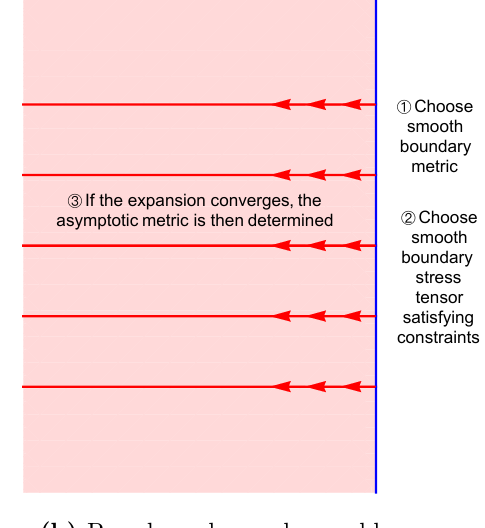
Figure 2. (a) Recipe for obtaining smooth bulk solutions given initial data and boundary data. (b) If the Fe(cid:11)erman-Graham expansion converges, one can obtain the asymptotic bulk solution from the boundary metric and boundary stress